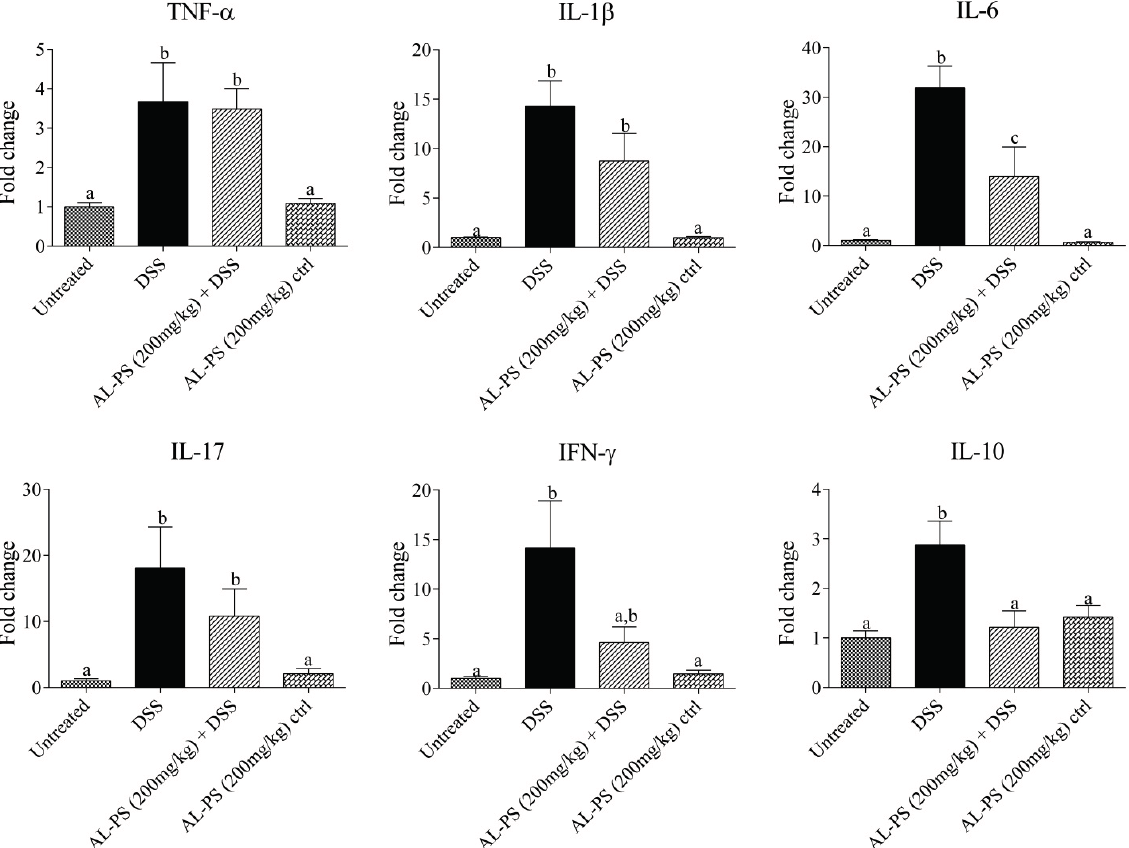
Figure 4. Effect of AL-PS on gene expression of pro-inflammatory and anti-inflammatory cytokines in DSS-induced colitis. RNA was isolated from colonic tissue and relative mRNA expression of TNF- α , IL-1 β , IL-6, IL-10, IL-17, and IFN- γ were measured by real-time RT-PCR. Results are reported as fold change relative to negative control (untreated) animals and data represent means ± SEM of n = 6 mice/group. Different letters indicate statistically significant differences at p < 0.05.